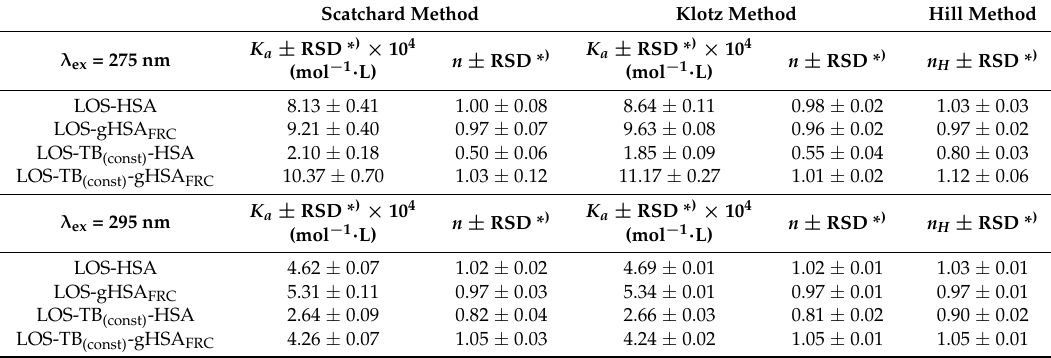
Table 6. Association constants K a (mol − 1 · L), mean number of LOS molecule bound with one molecule of HSA and gHSA FRC ( n ) , the Hill’s coefficient ( n H ) in the binary (LOS-HSA, LOS-gHSA FRC ) and ternary (LOS-TB (const) -HSA, LOS-TB (const) -gHSA FRC ) system; λ ex = 275 nm, λ ex = 295 nm. Scatchard Method Klotz Method Hill Method λ ex = 275